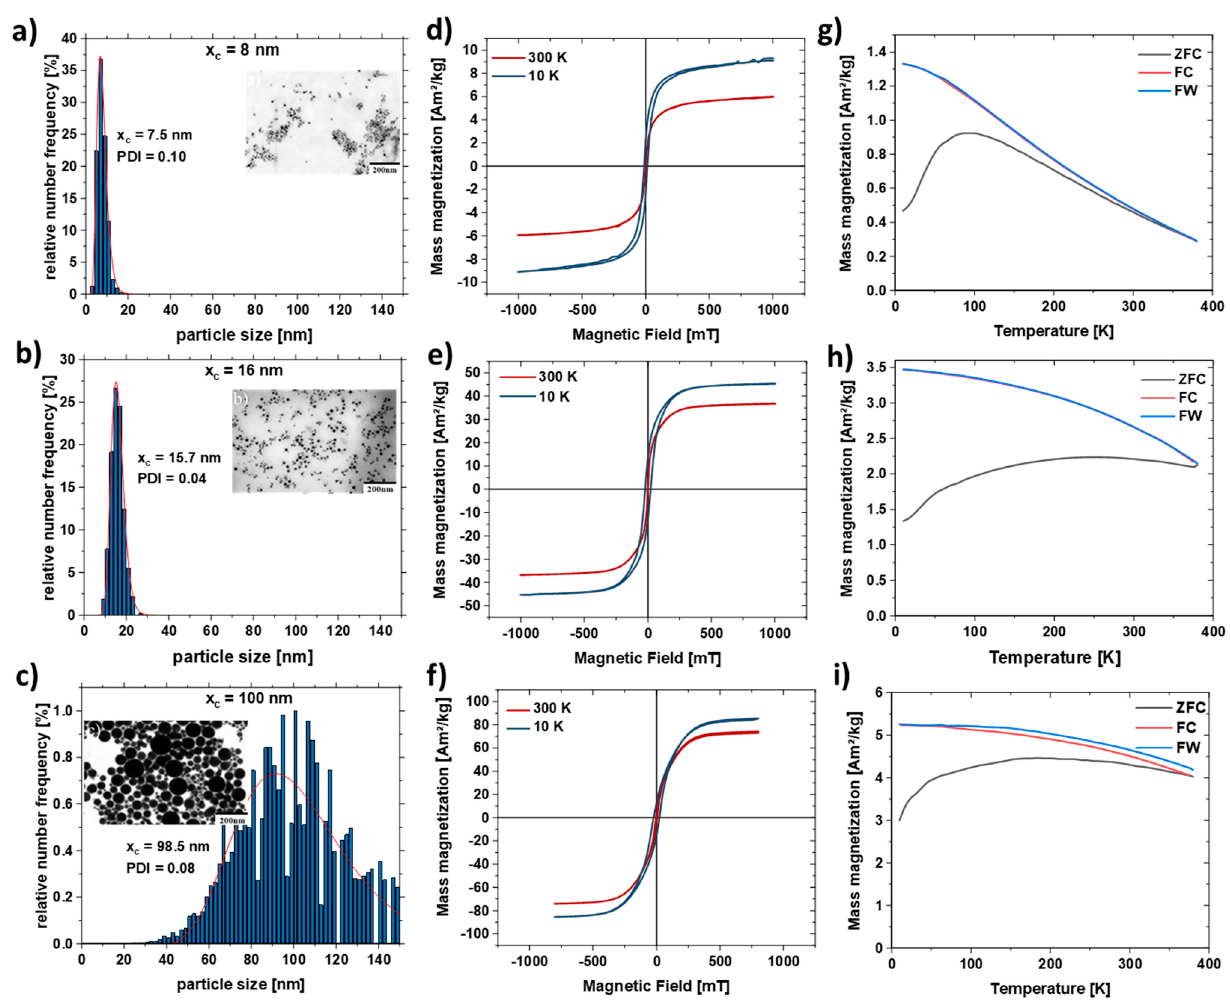
Figure 3. SEM images and particle size distributions of Fe 50 Ni 50 nanoparticles obtained after centrifugation of the as-is nanoparticle colloid with different RPMs to separate different size fractions with an average diameter of ( a ) 7.5 nm, ( b ) 15.7 nm, ( c ) 96.5 nm and their respective M(H) curve ( d – f ) at 300 K (red) and 10K (blue). ( g – i ) Temperature-dependent field cooled (FC, red), zero field cooled (ZFC, black) and field warmed (FW, blue) magnetization curves measured in 2 mT field for the respective FeNi nanoparticles.